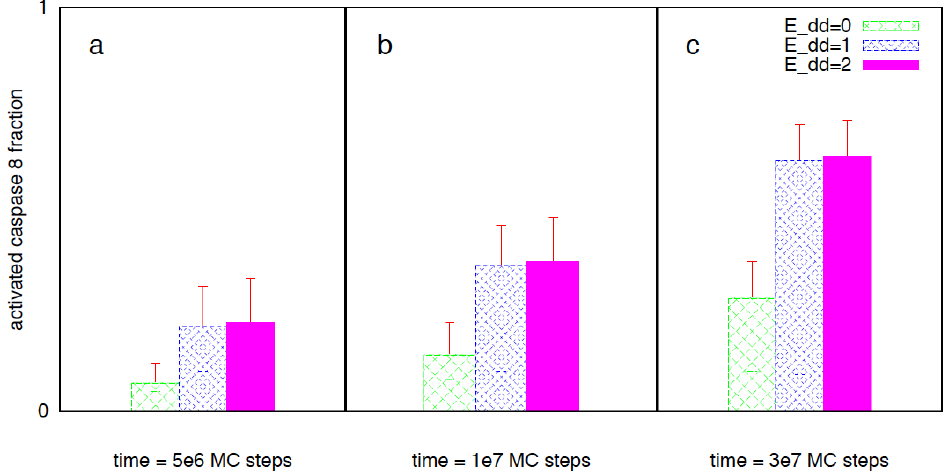
Figure 15. Activated caspase 8 (fraction of maximal) for three different values of DISC clustering energy: ( a ) E = 0, ( b ) E = −K T, ( c ) E = −2K T. Pon = 1 and Poff = 10 −3 dd dd B dd B are assumed. We simulated cancer cells having over-expressed Bid (2-fold), Bax (2-fold), Bcl2 (15-fold) and XIAP (3-fold). Data analyzed from 64 single cells (MC runs) are shown for three different time instants: 5 × 10 6 , 10 7 and 3 × 10 7 MC steps. Clustering of DISC (when E = −K T or −2K T) resulted in increased active caspase 8 generation and dd B B subsequent activation of effector